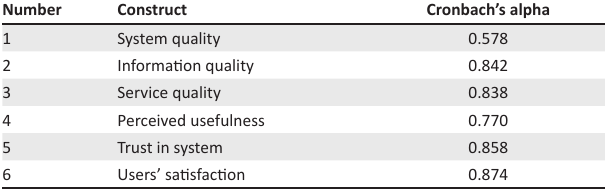
TABLE 2: Cronbach’s alpha coefficients for construct reliability measurement.